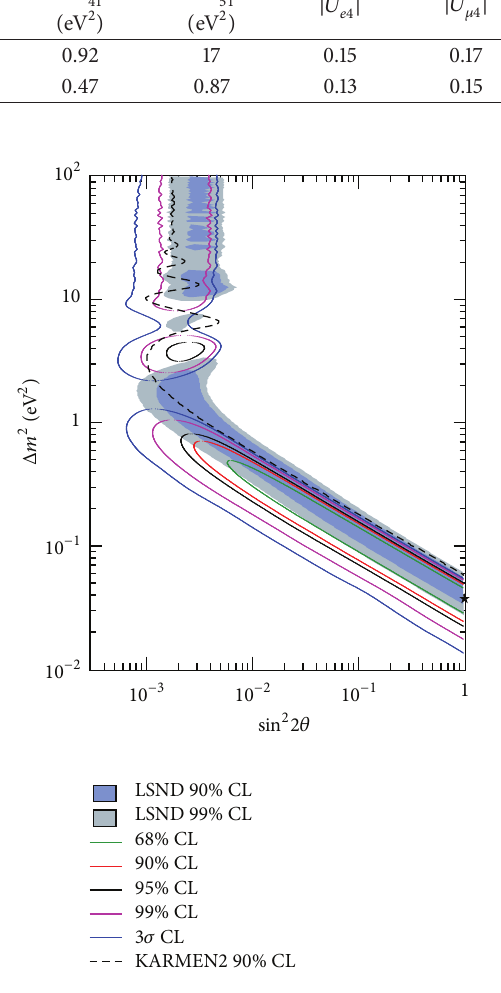
Figure 15: MiniBooNE allowed regions in combined neutrino and antineutrino mode for events with neutrino energy from 200 to 3000 MeV within a two-neutrino ] 𝜇 → ] 𝑒 and ] 𝜇 → ] 𝑒 oscillation model. Also shown is the ] 𝜇 → ] 𝑒 limit from the KARMEN experiment [26]. The shaded areas show the 90% and 99% CL LSND ] → ] 𝜇 𝑒 allowed regions. The black star shows the best fit point.